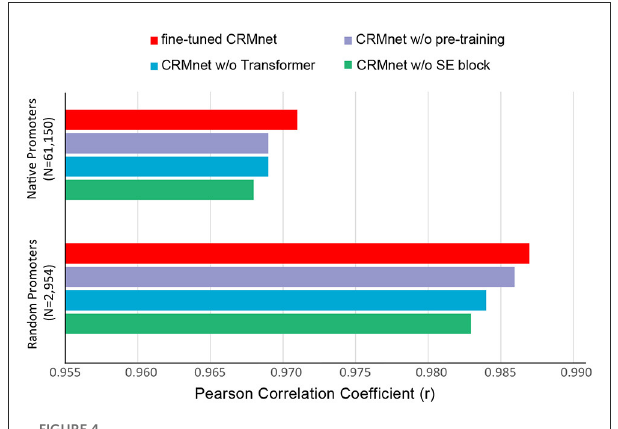
FIGURE4 Prediction performance for ablation study. Comparisons of prediction performance of models tested on native promoters and random promoters are shown: the full model with transfer learning (fine-tuned CRMnet, red), the model without transfer learning (CRMnet without pre-training, purple), the model without transformer block (CRMnet without transformer, blue), and the model without squeeze excitation (SE) block (CRMnet without SE block,